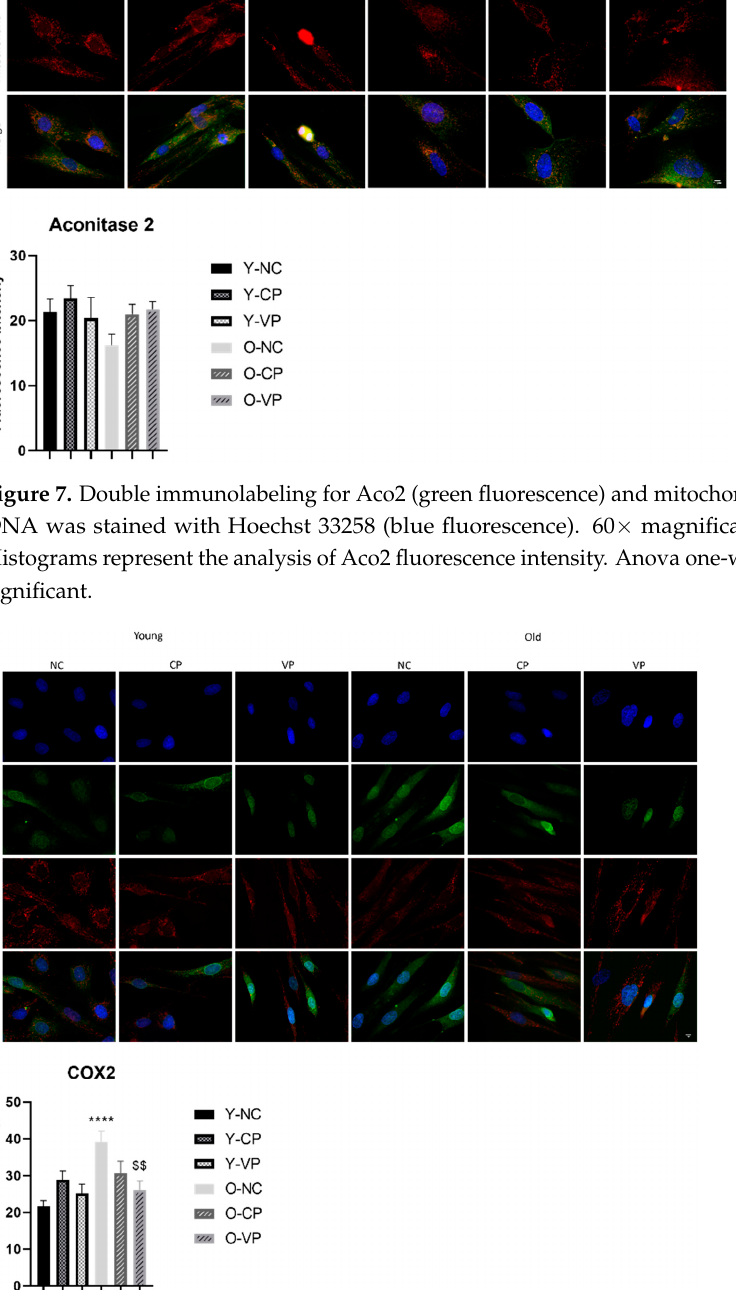
Figure 8. Double immunolabeling for COX2 (green fluorescence) and α -tubulin (red fluorescence); DNA was stained with Hoechst 33258 (blue fluorescence). 60× magnification; scale bar: 10 μ m. Histograms showing the analysis of COX2 fluorescence intensity; Anova one-way test: p = 0.0003; **** p < 0.0001, statistical significance between old NHDF untreated and young NHDF untreated; $$ p < 0.01, statistical significance between old NHDF treated with VP and old NHDF untreated.